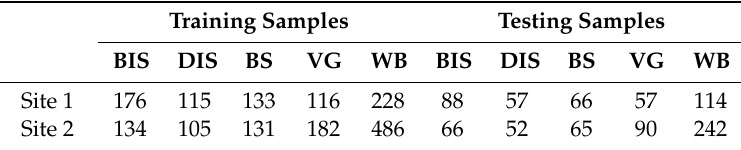
Table 1. The numbers of samples for Sites 1 and